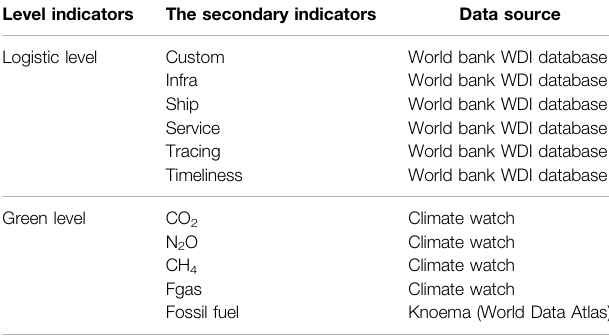
TABLE 2 | Sub-indexes of GLPI index and their sources.